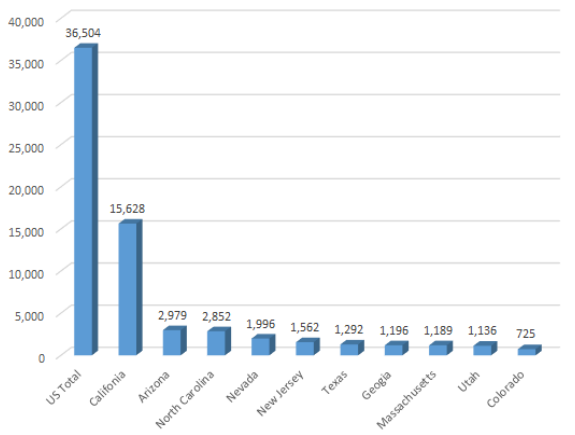
Figure 4. Top 10 net PV generation from utility and small scale year-to-date through June 2017 (Thousand Megawatthours).